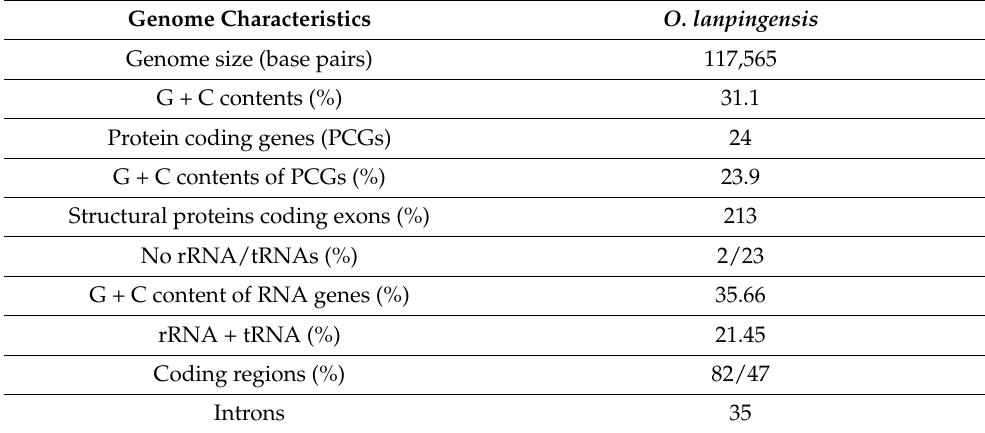
Table 1. General features in the mitogenome of O. lanpingensis